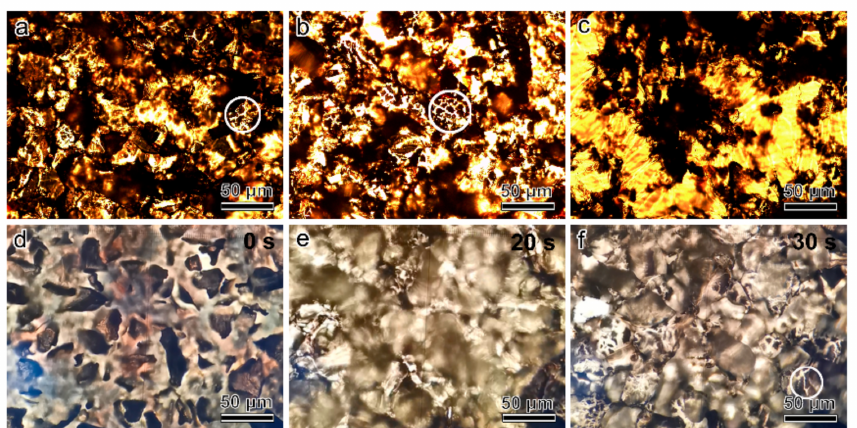
Figure 5. ( a ) Optical photograph of the Au-Gap/SAP structures (marked with the white circle) where the Au film thickness is 100 nm and the deionized water dropped is 2 µ L. ( b ) Optical photograph of the Au-Gap/SAP structures (marked with the white circle) where the Au film thickness is 200 nm and the deionized water dropped is 2 µ L. ( c ) Optical photograph of the Au-Gap/SAP structures where the Au film thickness is 200 nm and the deionized water dropped is 20 µ L. ( d ) Video snapshot before dropping deionized water. ( e ) Video snapshot when dropping 5 µ L deionized water. ( f ) Video snapshot after dropping deionized water for about 10 s and the Au-Gap/SAP structures are marked with the white